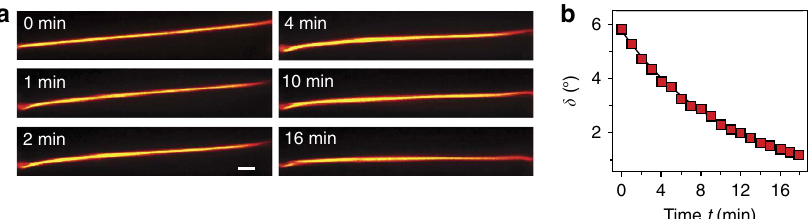
Figure 4 | Time relaxation of the soliton path. The magnetic field had been oriented at the angle y m ¼ 50 (cid:2) in the yz plane before it was switched off at the moment t ¼ 0min. ( a ) Photographs of time sequence of soliton trajectories in the yz plane. The white scale bar, 100 m m. ( b ) Measured temporal evolution of walk-off angle (squares). The solid line is the exponential fit d ¼ d 0 exp( (cid:2) t / t ), with t ¼